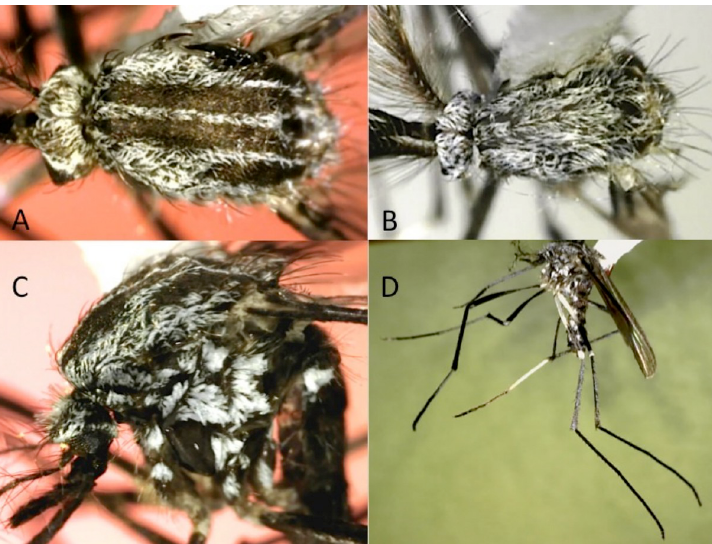
Fig 6. Adult of Aedes ( Protomacleaya ) lewnielseni . A: Dorsal view of the scutum (female). B: Dorsal view of the scutum (male). C: Lateral view of thorax (female). D: Lateral view of body (female). and brown-scaled. Legs : Predominately dark-scaled, white scales on posterior surface of fore- and midfemora, on basal 0.5–0.6 of hindfemur, in large knee spots on mid- and hindleg, on underside of foretarsomere 1, and on basal 0.8–0.9 of midtarsomere 1; hindtarsus dark-scaled. Abdomen : Tergum I with long setae, a few brown and white scales dorsally, and large patch of white broad flat scales on laterotergite; terga and sterna II–VII dark-scaled with basolateral white patches, the terga sometimes with additional basal white scales.